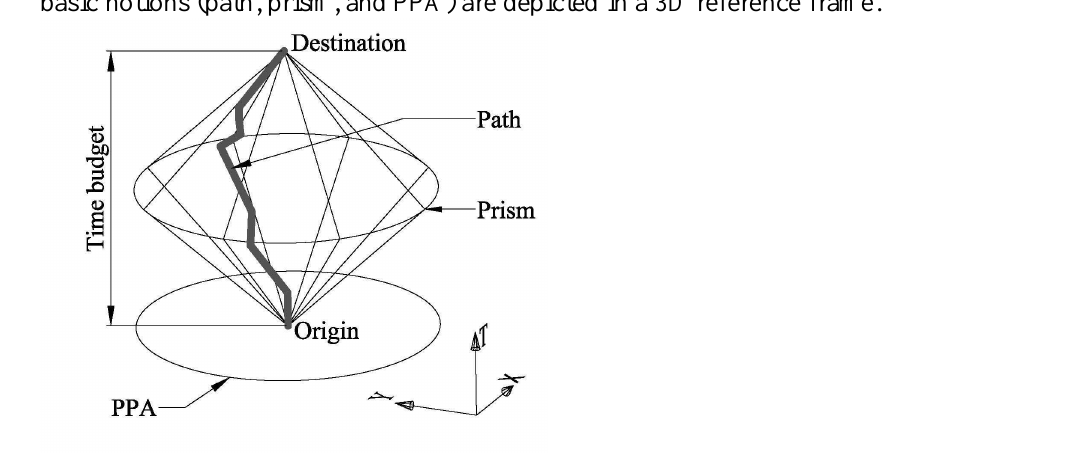
Figure 1. Time geographical concepts: space-time path, space-time prism, and potential path